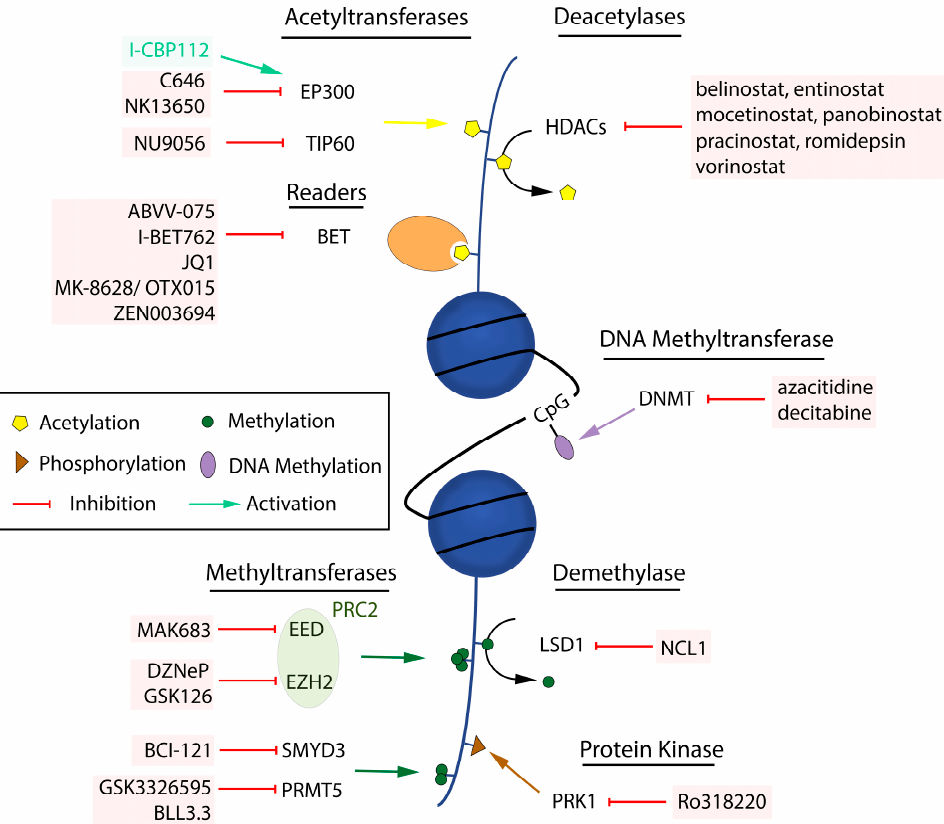
Figure 1. Overview of potential epigenetic targets and selected inhibitors. Straight arrows indicate the addition of acetyl (yellow), methyl (dark green) or phosphoryl (brown) groups to histones, or of a methyl group (purple) to DNA. Removal of these groups is indicated by half-circular black arrows.